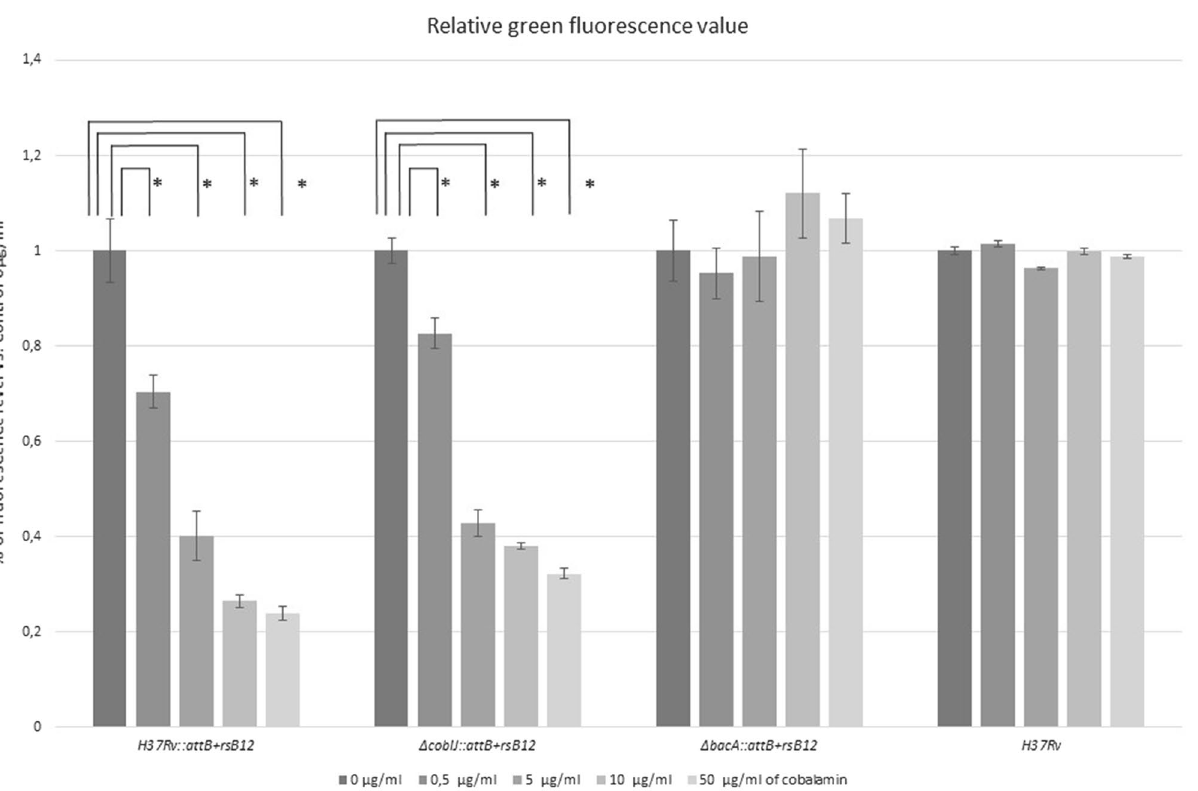
Figure 5. The evaluation of the protein expression of gfp gene under the control of vitamin B12- dependent riboswitch, based on the green fluorescence. We used a Guava flow cytometer to evaluate the green fluorescence in cells of H37Rv:: attB + rsB12, ∆ bacA :: attB + rsB12, ∆ cobIJ :: attB + rsB12, carrying the gene of GFP under the control of the metE promoter, controlled by a vitamin B12-dependent riboswitch. We observed that the green fluorescence of strains H37Rv:: attB + rsB12 and ∆ cobIJ :: attB + rsB12 significantly differed from the control strains grown in medium without exogenous vitamin B12 supplementation. Each strain was analyzed in samples collected from three cultures. Statistical analysis was performed with paired t-test. Whiskers represent